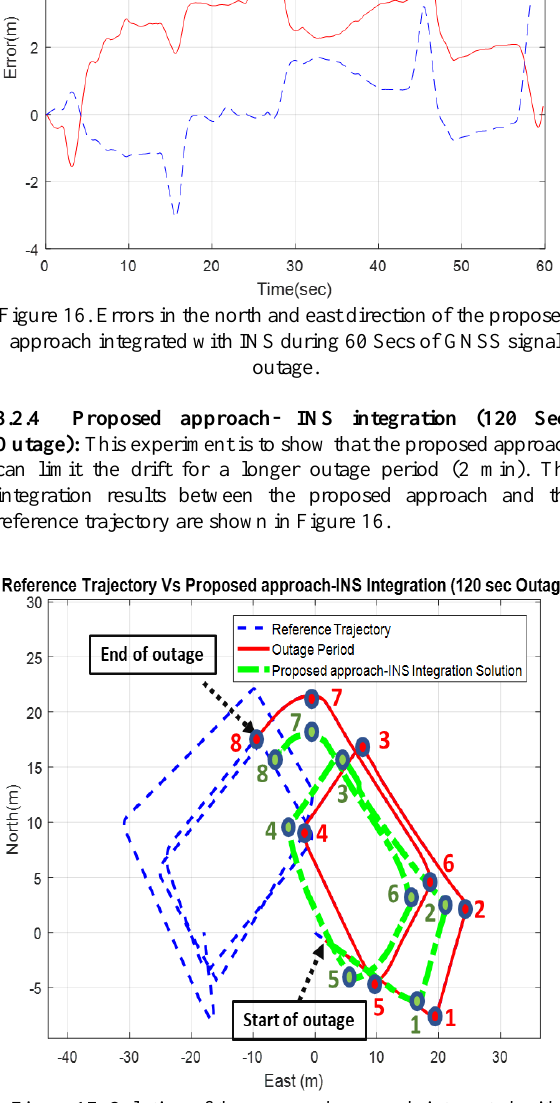
Figure 17. Solution of the proposed approach integrated with INS during 120 Secs of GNSS signal outage.